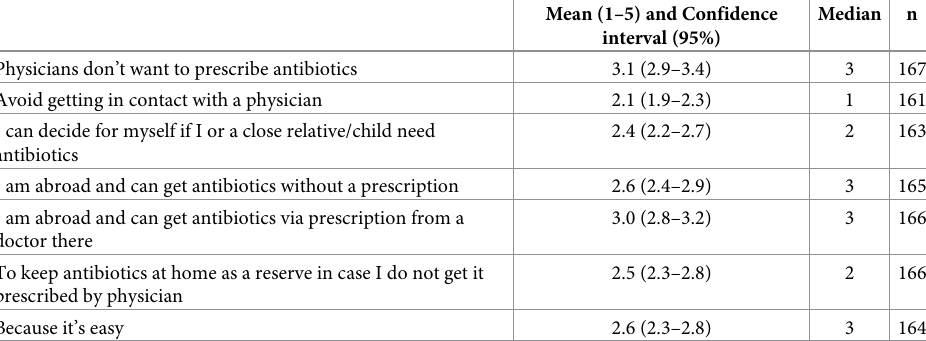
Mean (1–5) and Confidence Median interval (95%)